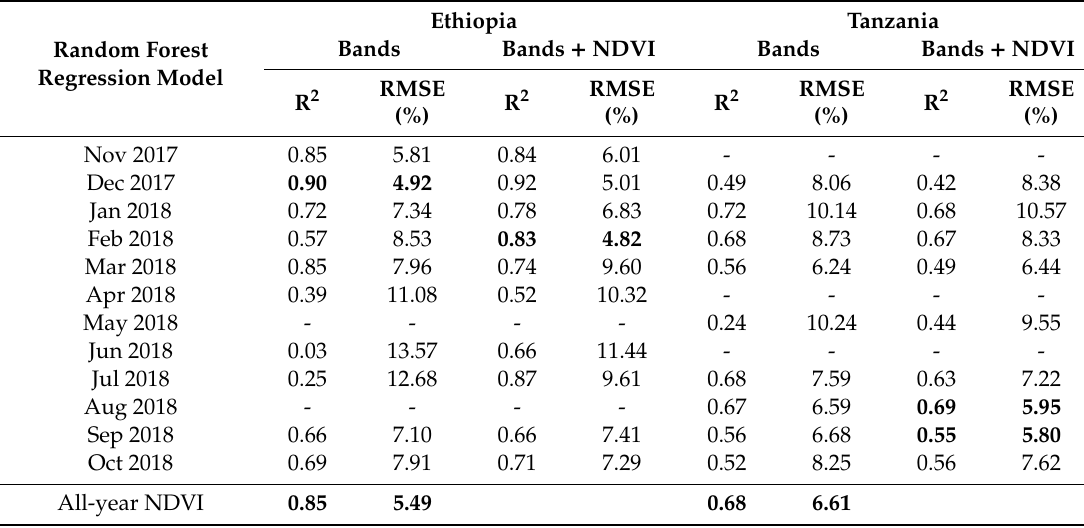
Table 6. R 2 and RMSE of the Random Forest regression models for Ethiopia and Tanzania separately (Scenario 1). ‘-‘ means some plots were covered by clouds, so R 2 and RMSE could not be calculated. In the all-year NDVI-regression in Ethiopia, May and August 2018 were left out, while in Tanzania, November 2017 and April and June 2018 were left out. The three best performing models for each study site are marked in bold.